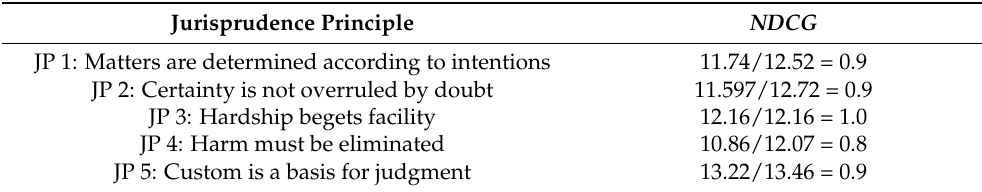
Table 4. Ranking performance of each